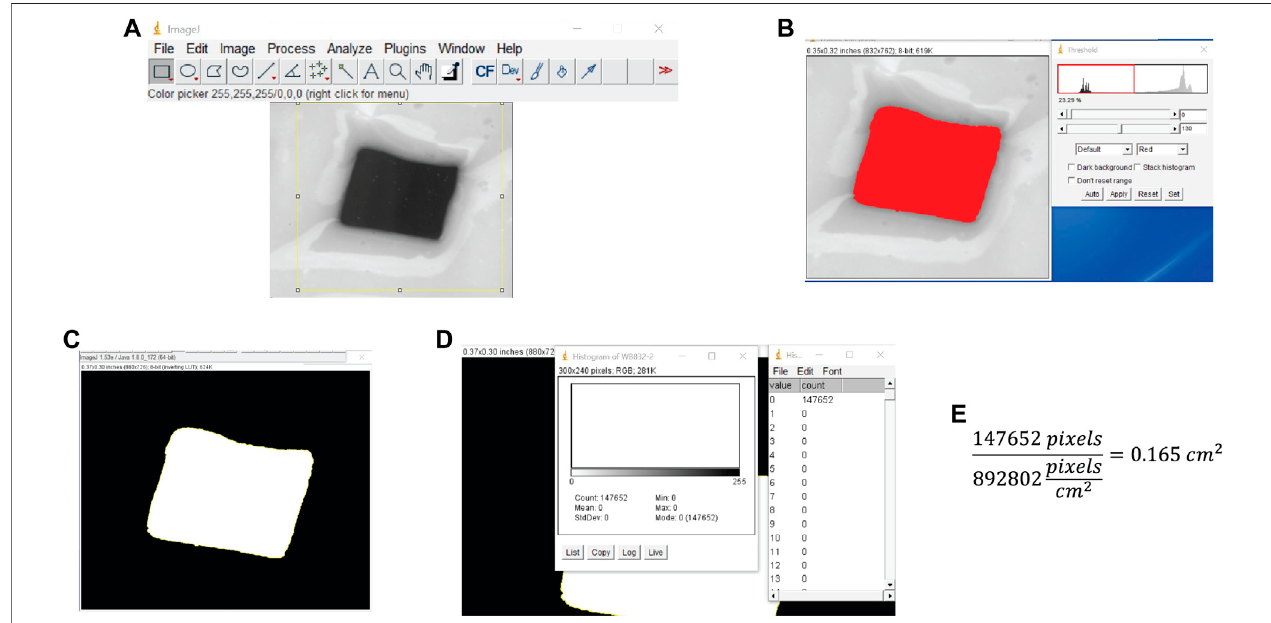
FIGURE 3 | Test electrode area determination. (A) Image is cropped to isolate the electrode surface. (B) The threshold is set by adjusting the slider to fi ll the entire electrode area while excluding surrounding epoxy. (C) The area is selected and fi lled to get a black and white image. (D) The number of pixels in the electrode surface area is determined using the histogram. (E) The surface area is computed by dividing the number of pixels in the surface area by the scan resolution in pixels/cm 2 .